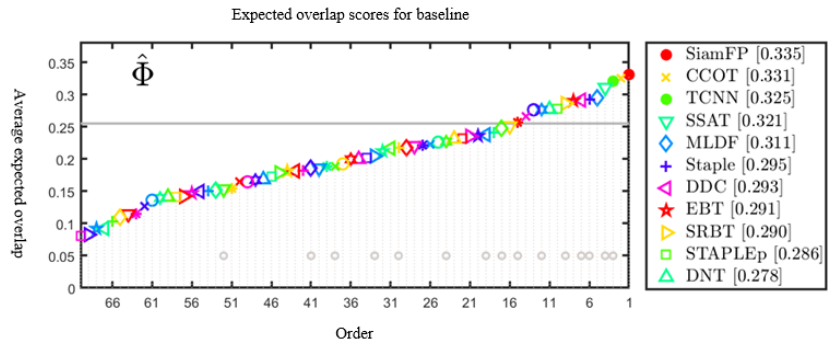
Figure 7. EAO Results on VOT2016 Dataset.